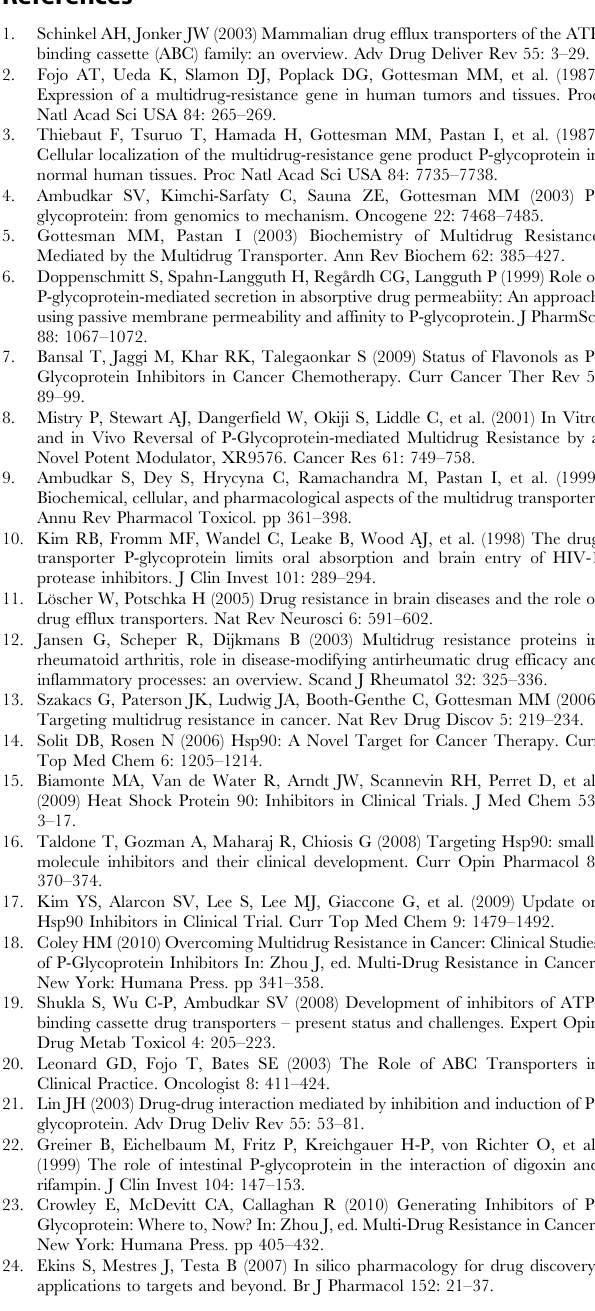
Table S1 Selected compounds for this study, their names, SMILES strings, observed pEC50 values and predicted values by Hypo A, Hypo B, Hypo C and PhE/ SVM, data partitions and